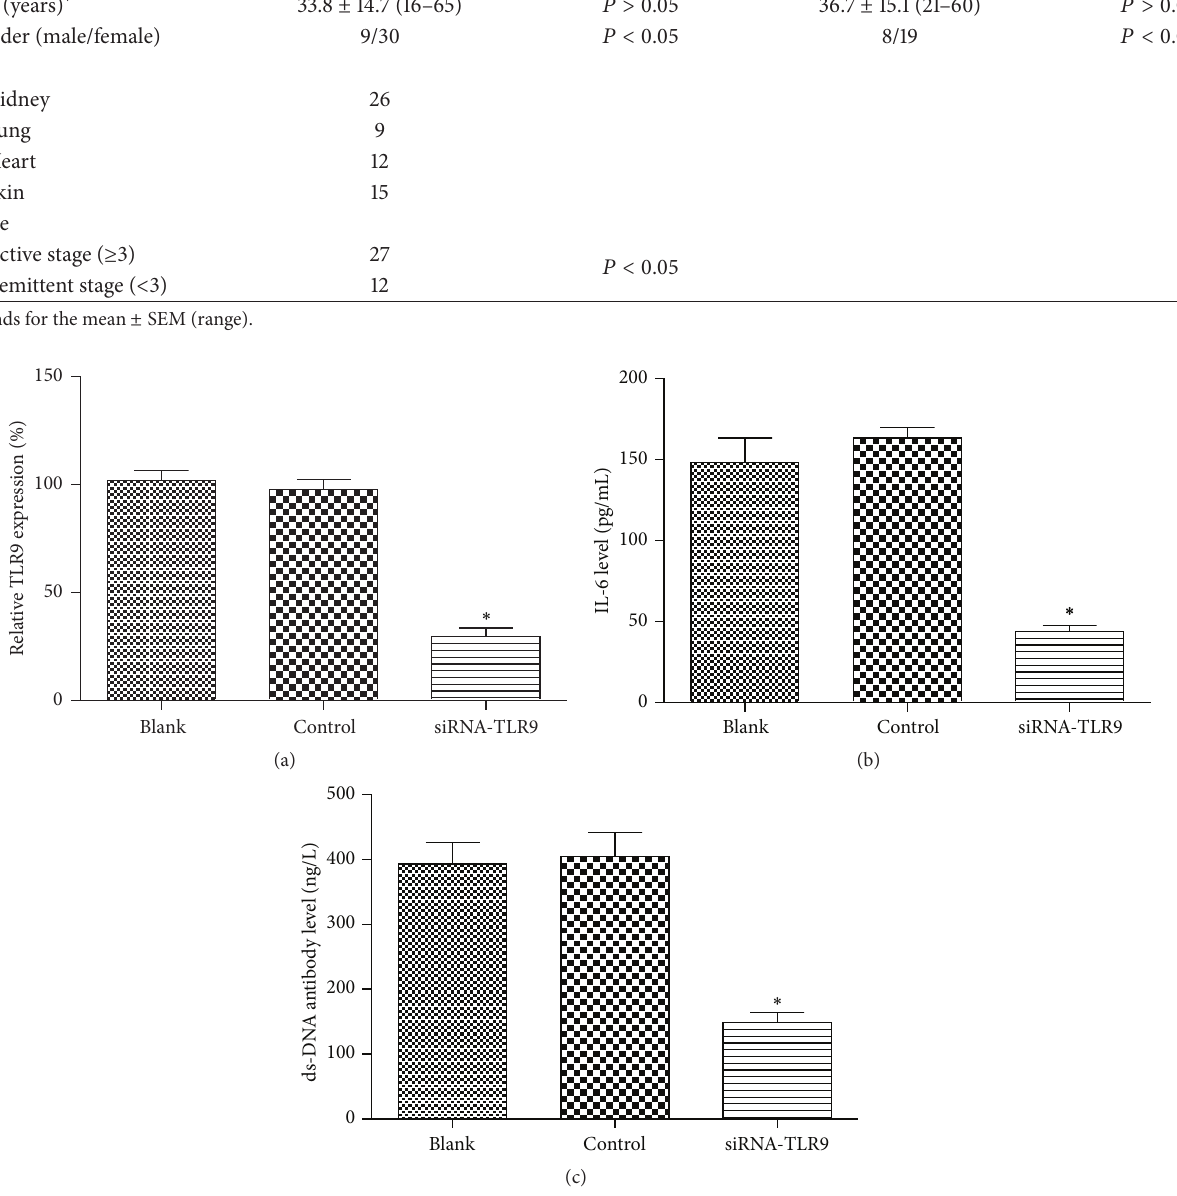
Figure 3: Correlation between silencing TLR9 and cytokine expressions in B cells from SLE patients. (a) TLR9 expression in each group of B cells;afterbeingtransfectedwithsiRNA-TLR9,TLR9inBcellswassignificantlydeclined;(b)IL-6levelinBcellstransfectedwithsiRNA-TLR9 plasma; (c) ds-DNA level in B cells transfected with siRNA-TLR9 plasma. ∗ 𝑃 < 0.05 , compared with the